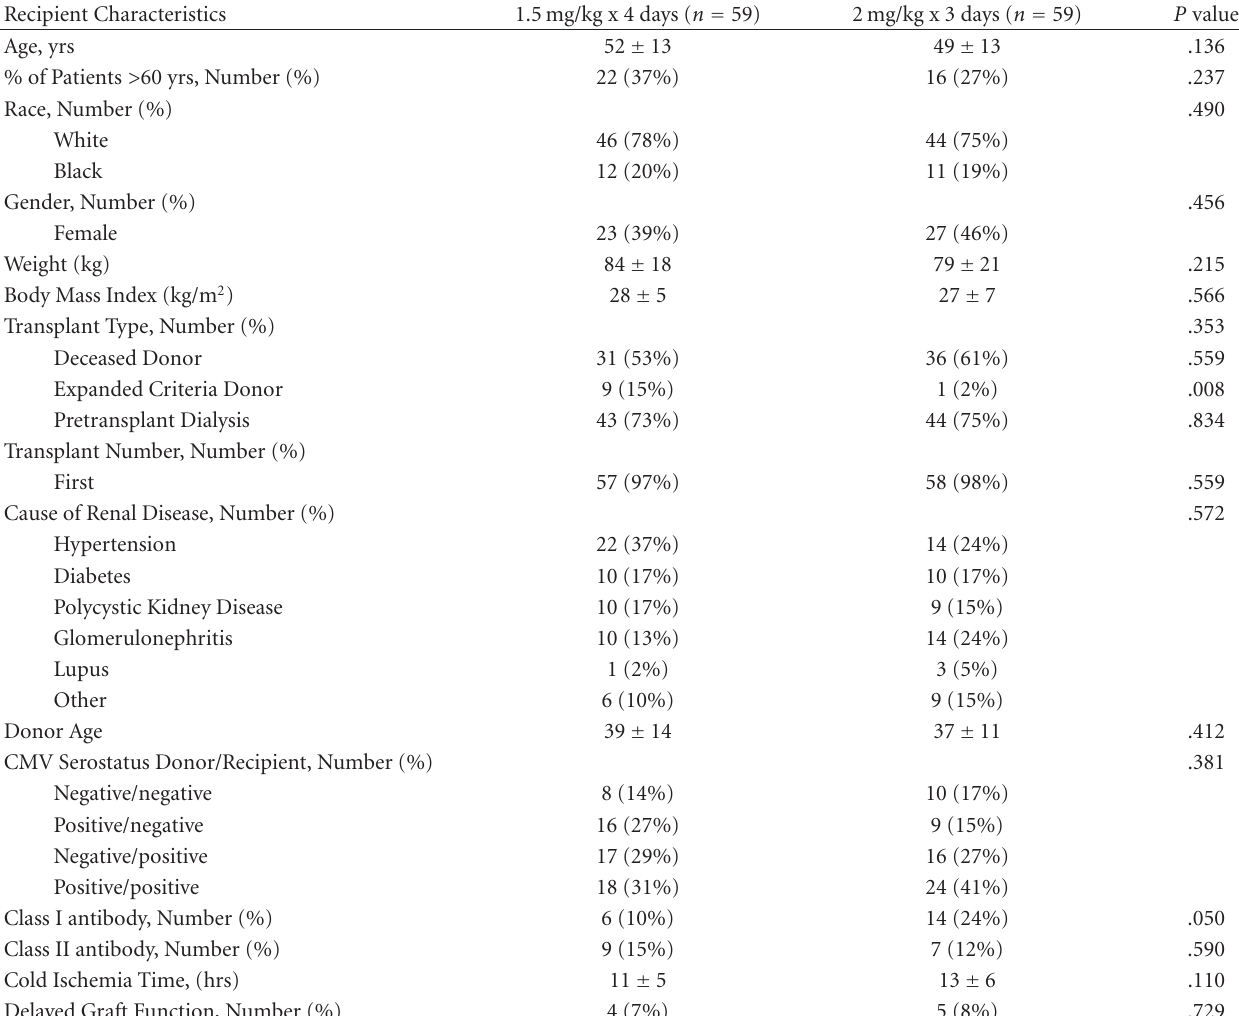
Table 1: Recipient and Donor